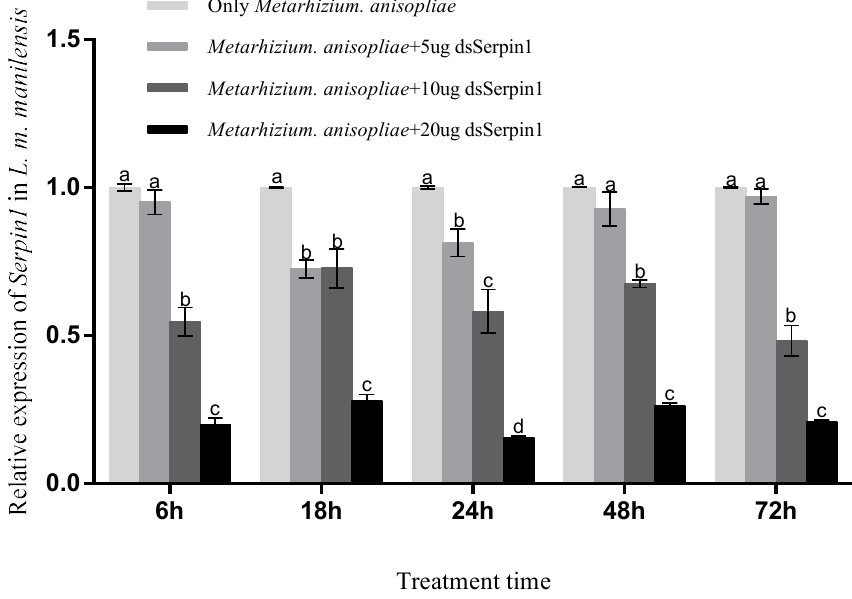
Figure 1. Relative expression of Serpin1 in L. m. manilensis showing the effect of feeding different dosages of dsSerpin1 with M. anisopliae at five points in time after treatment administration. (There were differences between a–d representatives and other groups)